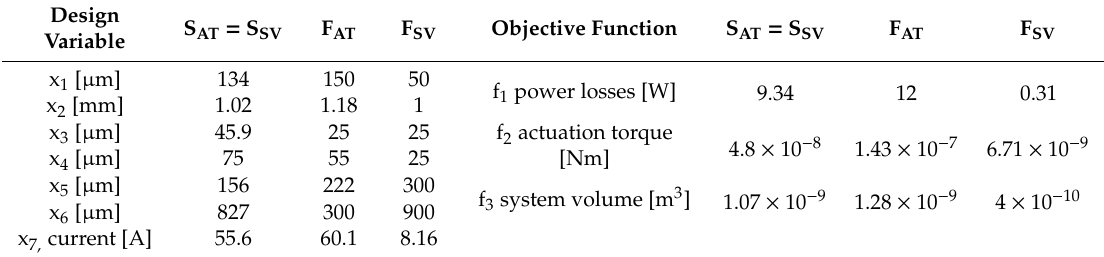
Table 4. Values of the design variables and objective functions of solutions with highest actuation torque (S AT and F AT ) and lowest system volume (S SV and F SV ).